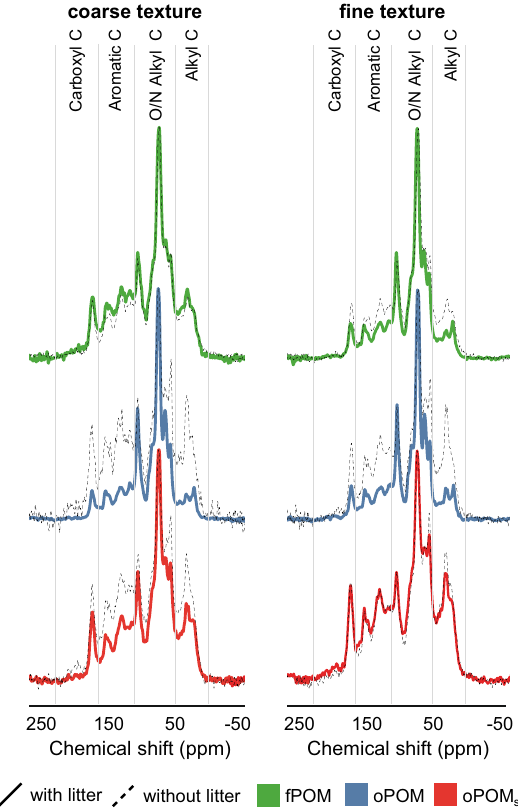
Fig. 3 Differences in the chemical composition of particulate OM fractions. Solid-state 13 C CP-MAS NMR spectra displaying the chemical compositions of free particulate organic matter (fPOM) and occluded POM (oPOM, oPOM small ) in coarse-textured and fi ne-textured soil (control samples in black). The chemical shift regions represent the following functional groups: 0-45 ppm (alkyl C), 45 – 110 ppm (O/N alkyl C), 110 – 160 ppm (aromatic C), and 160 – 220 ppm (carboxyl C). n = 3 independent replicates for fPOM with litter (both textures), oPOM with litter (both textures), and oPOM small with litter in the fi ner texture. For the rest of the samples, n =